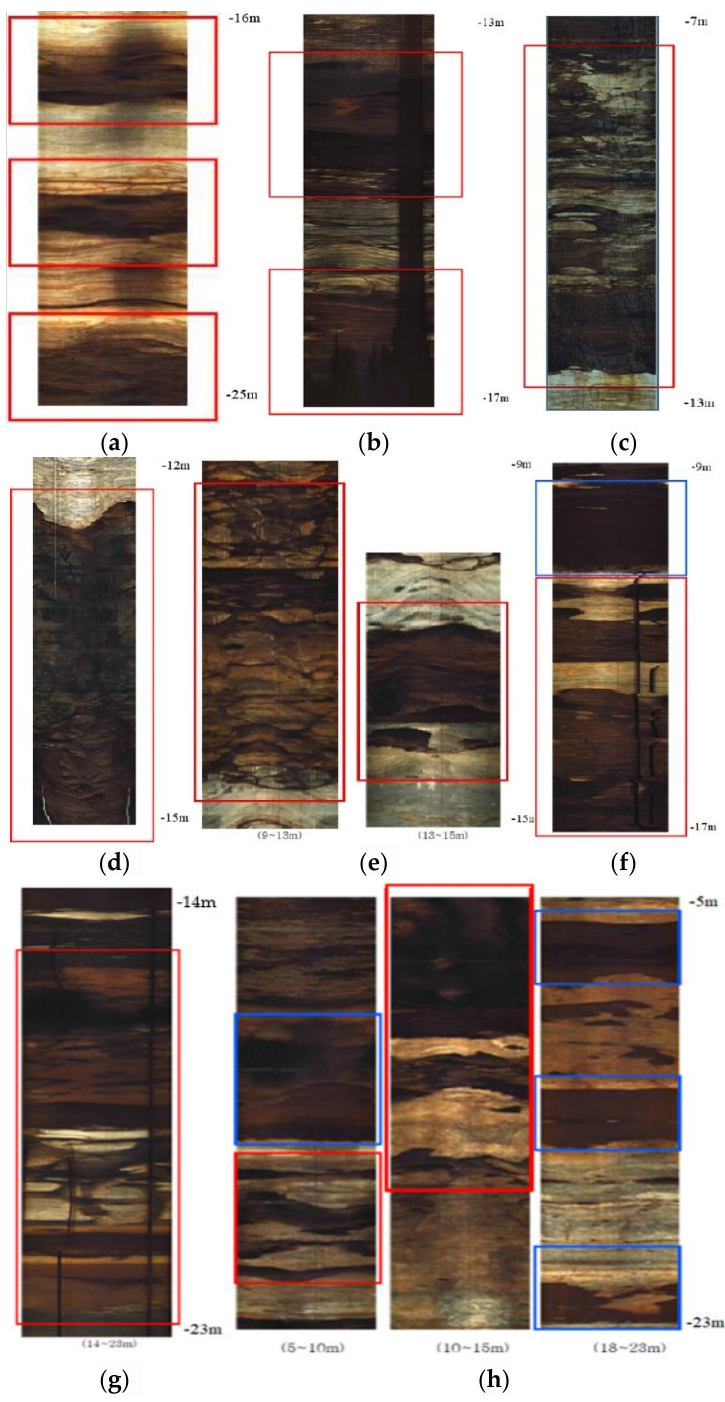
Figure 24. BIPS images showing clay filled fracture zones and potential cavities, ( a ) BH-3, ( b ) BH-4, ( c ) BH-5-1, ( d ) BH-6, ( e ) BH-7, ( f ) BH-8, ( g ) BH-9, ( h ) BH-10.